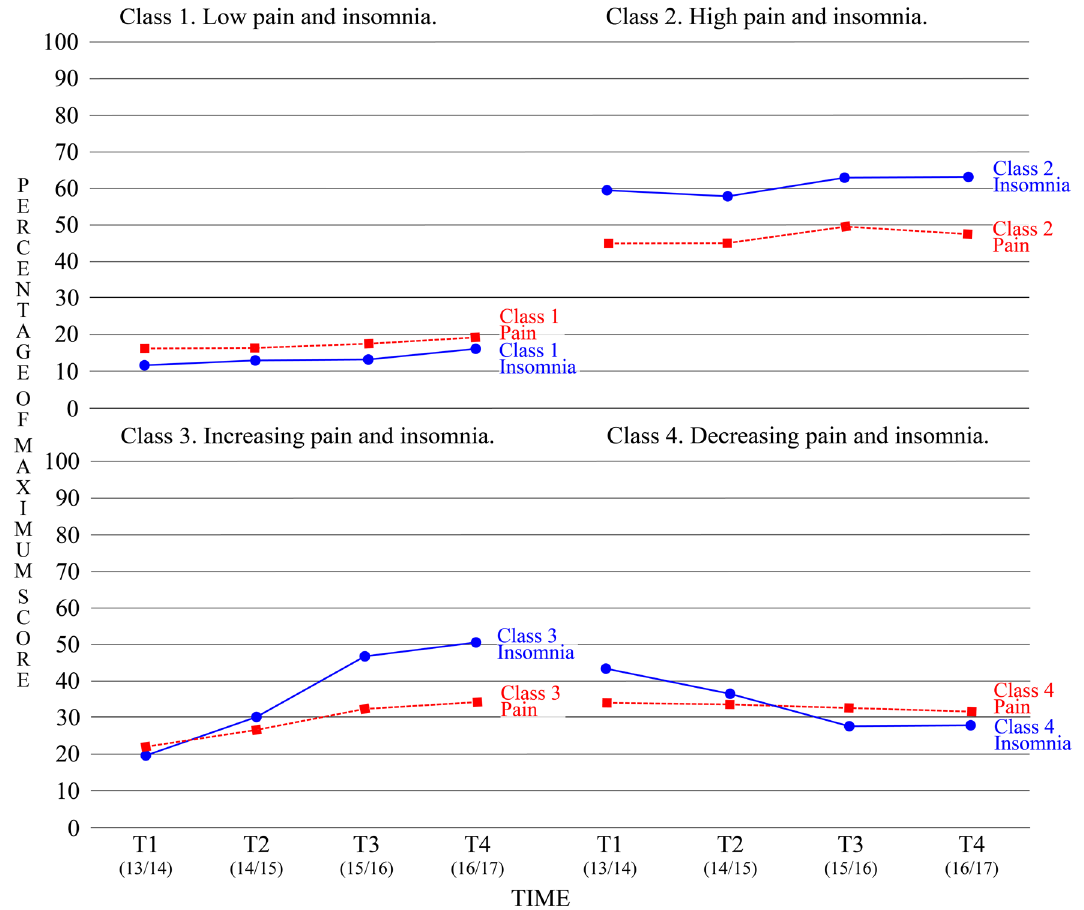
Figure 1. Longitudinal class solution of conjoint pain and insomnia development. The trajectories of pain are in red color (dotted line), and the trajectories of insomnia are in blue (solid line). The y-axis in the diagrams, which ranges from 0 to 100, represents percentage of maximum score of both insomnia symptoms and pain grade to facilitate comparisons of the trajectories. The x-axis represents measurement occasion, ranging from T1 to T4, and the numbers within parentheses are the age cohorts (in years) at each time